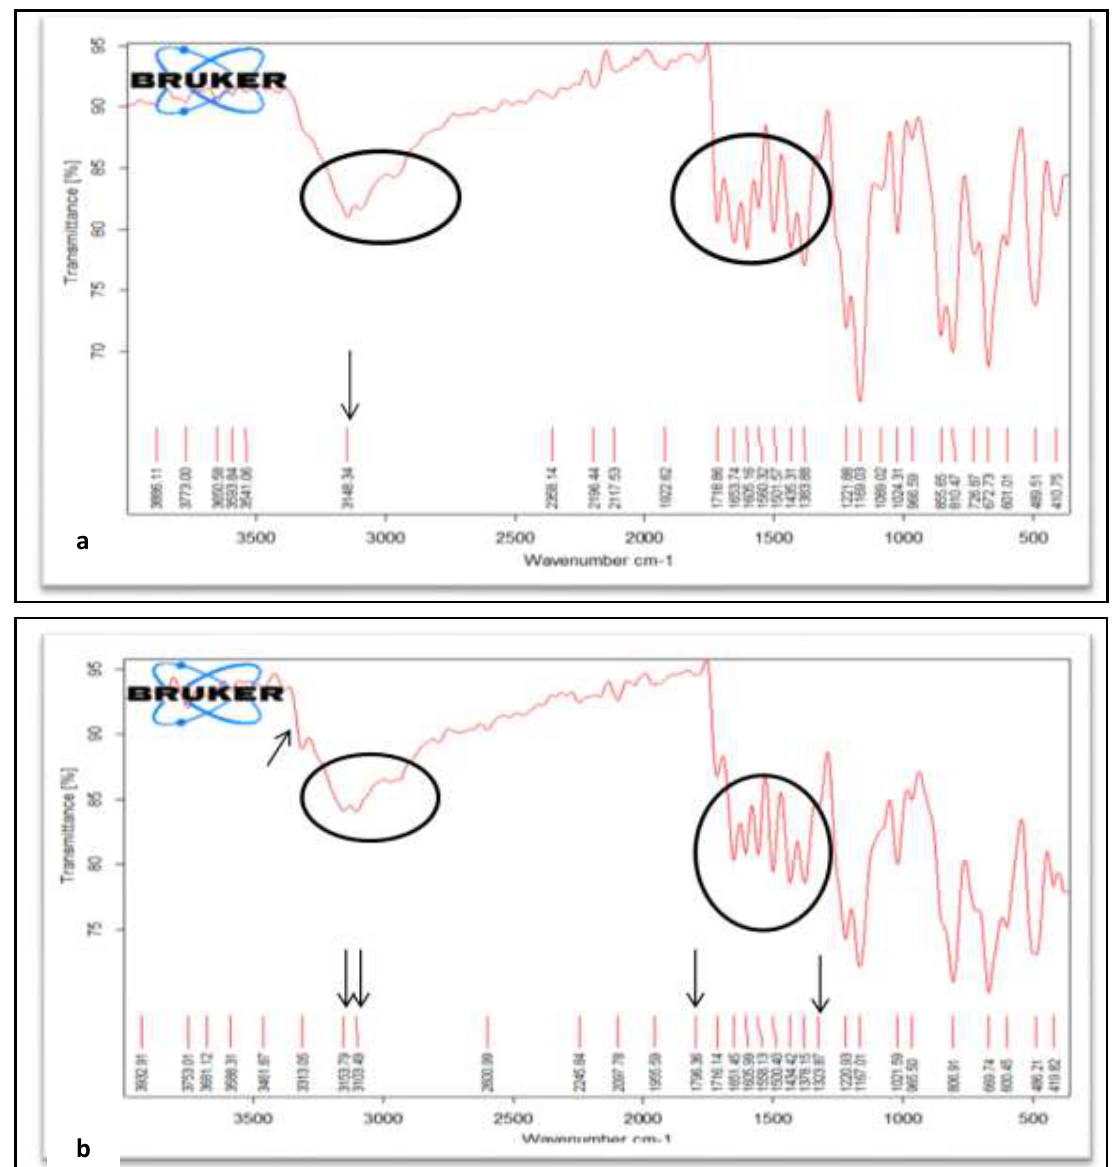
Figure 5. FTIR spectrum of 2:1 paracetamol/ naproxen mixtures.a) C2 physical mixture. b) N2 prepared co-crystal